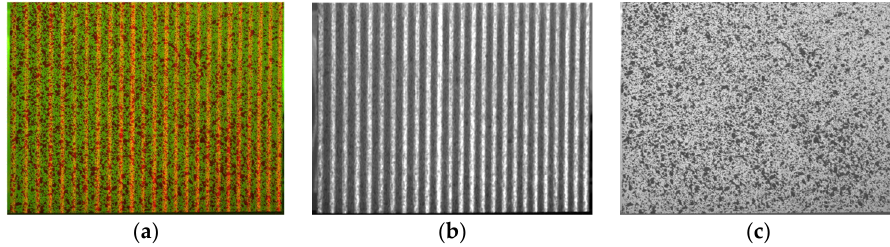
Figure 6 . Image RGB decomposing employing the laser projection process. ( a ) Original RGB image; ( b ) fringe image; ( c ) speckle image.